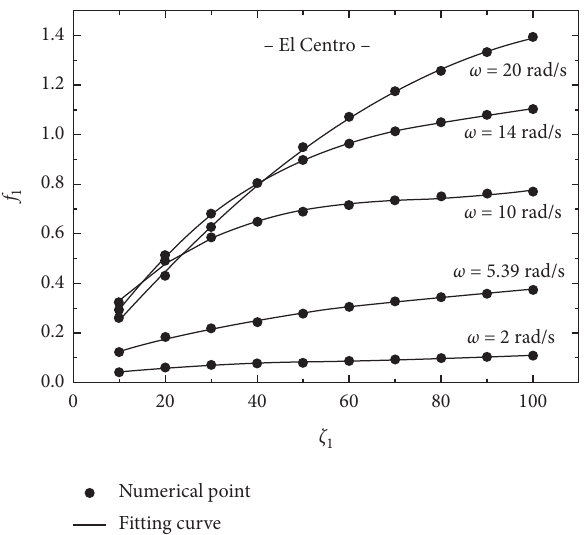
Figure 10: Relationship between f 1 and ζ 1 under El Centro seismic excitation. Figure 12: Relationship between the ADR and the seismic-exci- tation peak acceleration with different values of c a (kN · s/m) for the Table 1: Fitting coefficients of the polynomial for different ω El Centro ground motion ( α � values.